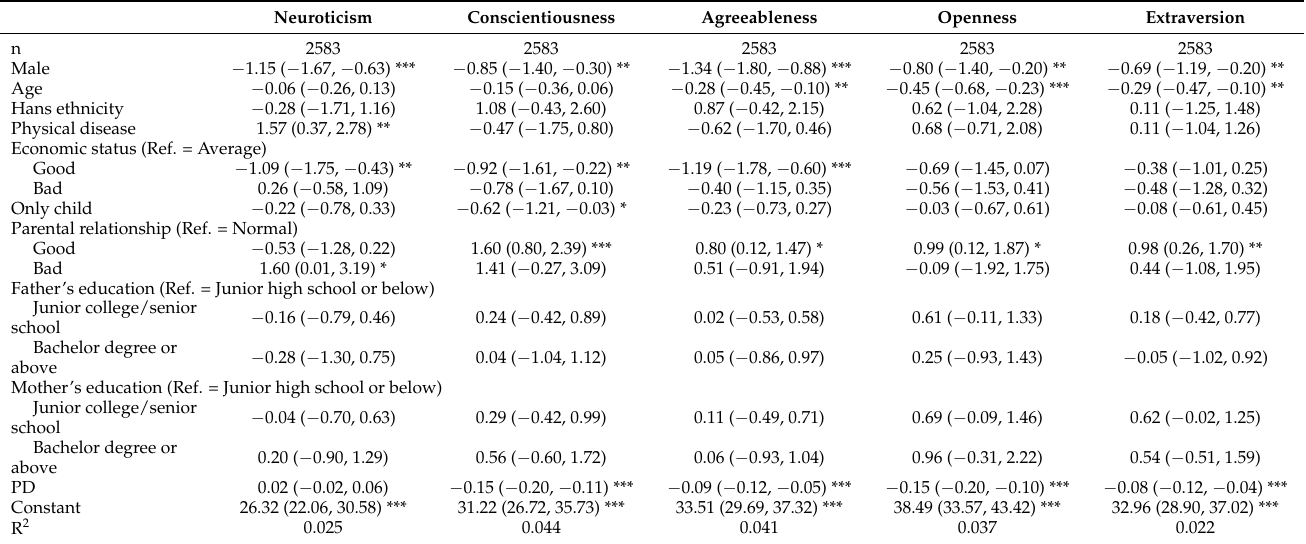
Table 4. Linear regression for the factors associated with big five personality dimensions ( β (95% CI)).